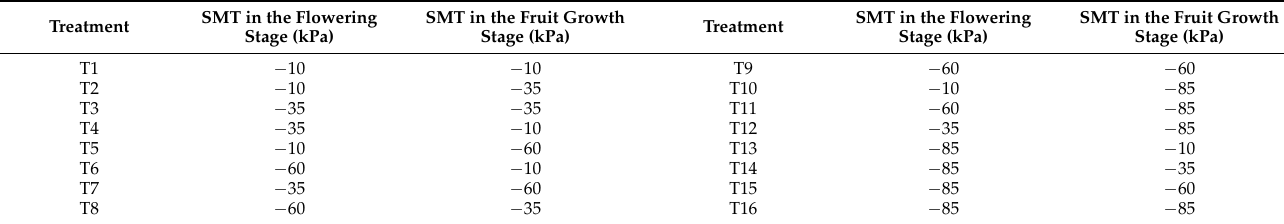
Table 1. Soil water moisture tension (SMT)